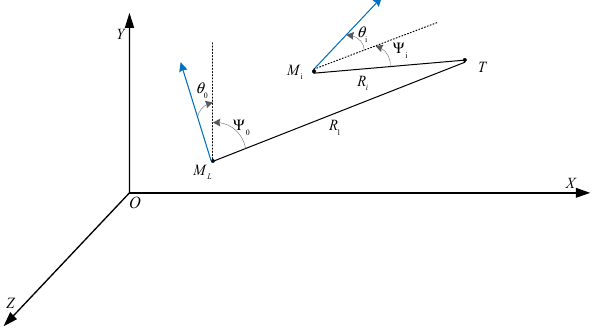
Figure 2. Relative motion relationship of the leader-follower missiles.